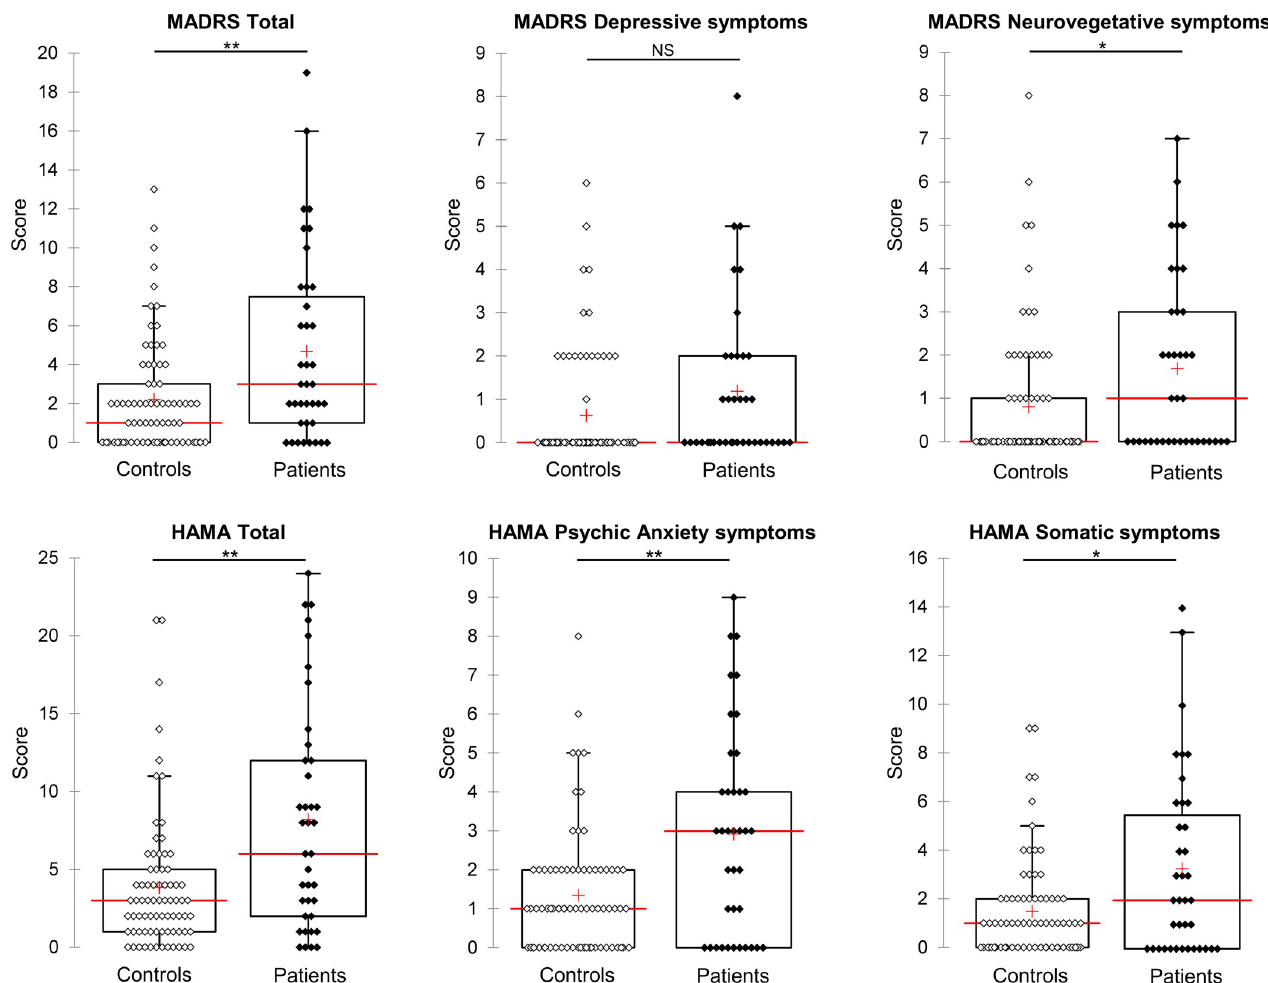
Fig 1. Comparison of MADRS, HAMA and symptom scores between patients and controls. Patients (in black) had significantly higher scores than controls (in white) for MADRS and HAMA total scores and for neurovegetative, psychic anxiety and somatic symptom scores. Scores are presented as Box plot with interquartile range and 95% confidence interval. Median and mean scores are presented as red line and red cross respectively. � p < 0.05 and �� p < 0.01. NS, non-significant.